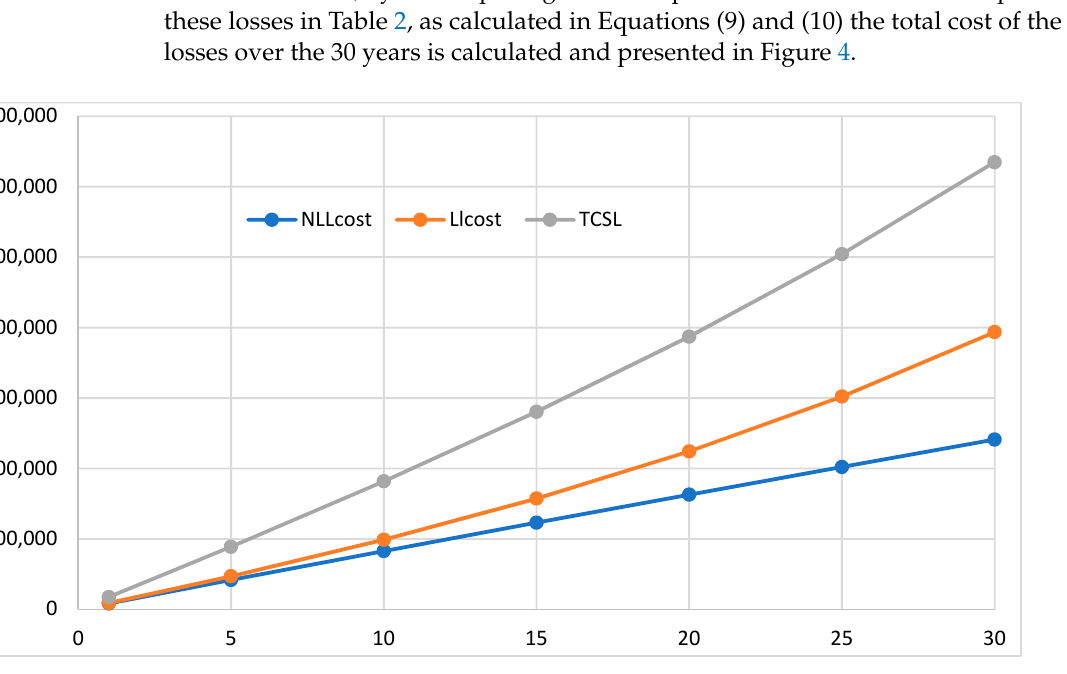
Figure 4. The total cost of service losses ( 𝑇 (cid:3004)(cid:3020)(cid:3013) ): proposed method.